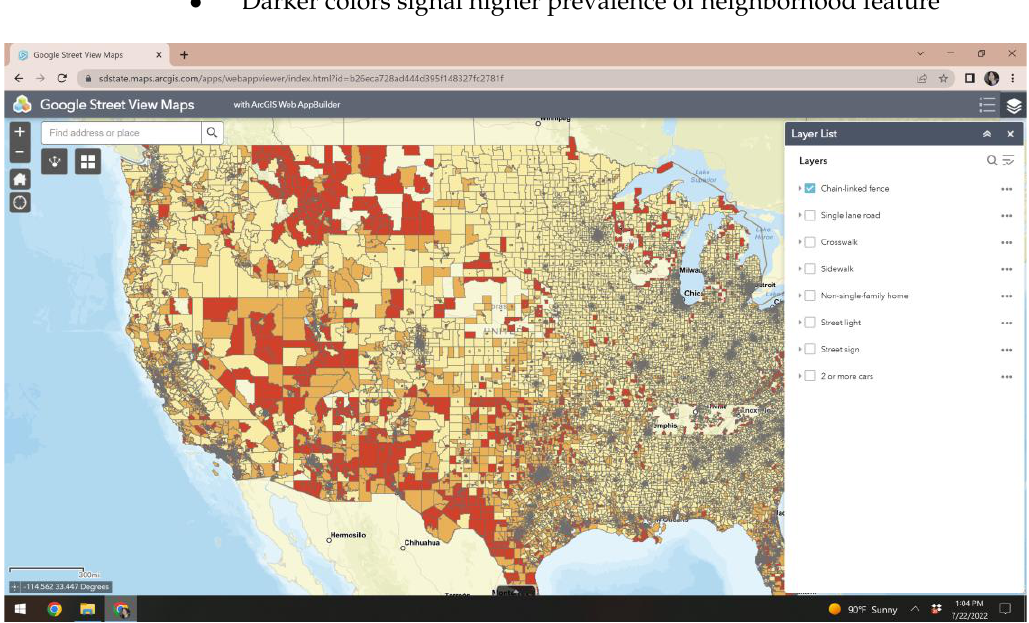
Figure 2. Geoportal interface. Darker colors signal higher prevalence of a neighborhood